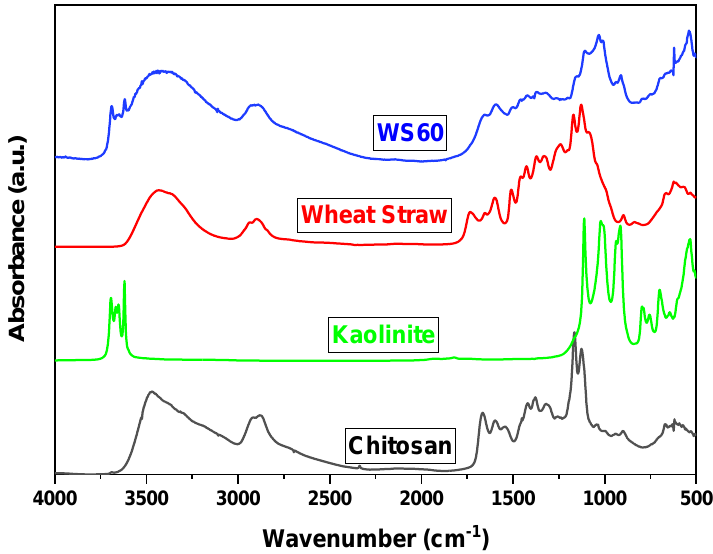
Figure 1. FT-IR spectra of chitosan, kaolinite, torrefied wheat straw and the WS60 biocomposite pellet material.